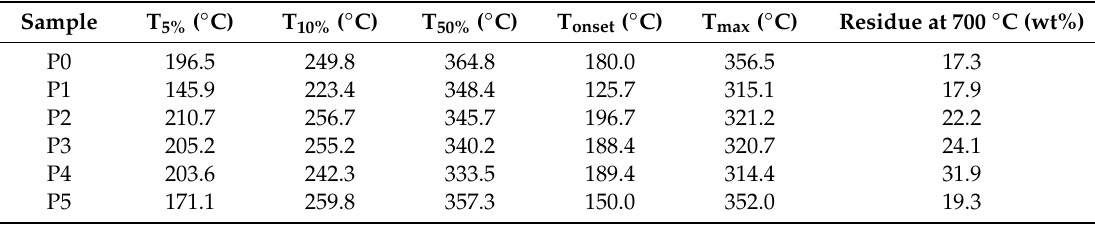
Figure 6. Thermogravimetric curve of di ff erent contents of IL-EG / DPES-modified flame-retardant RPUFs. Table 3. TG and DTG data for the various